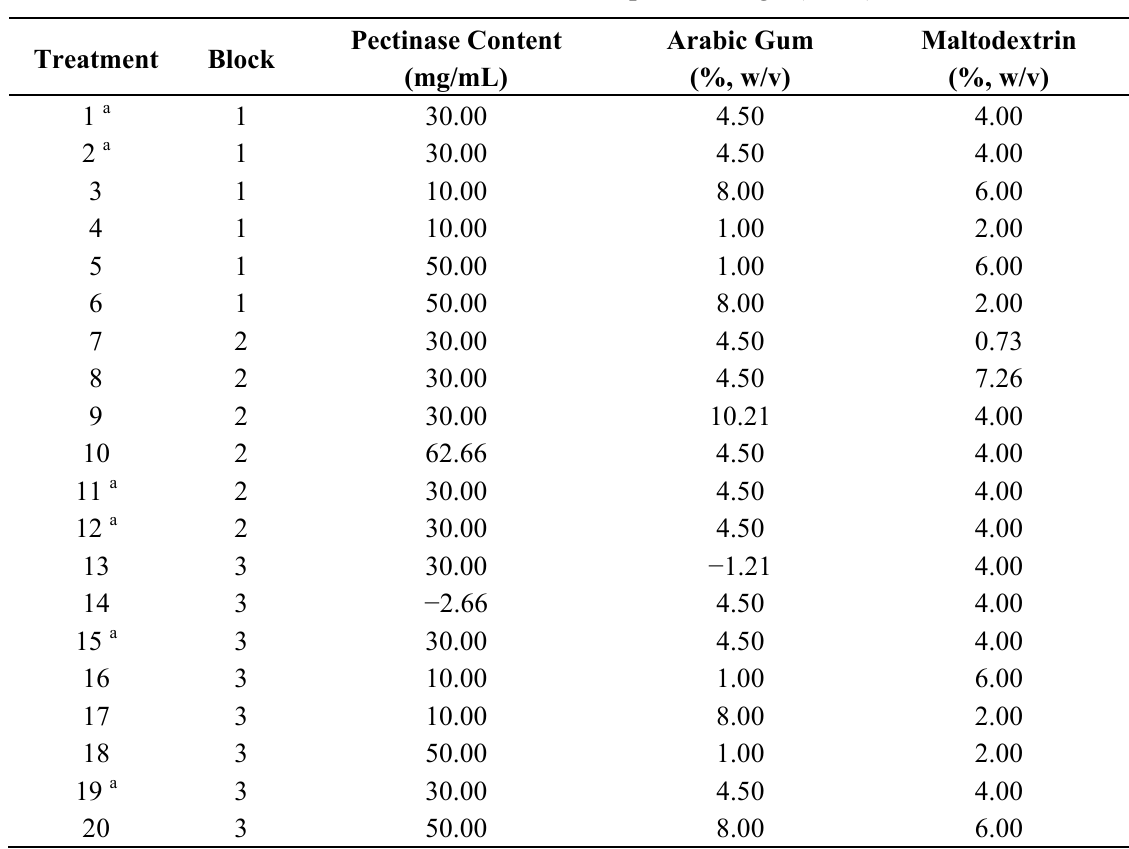
Table 4. Matrix of central composite design